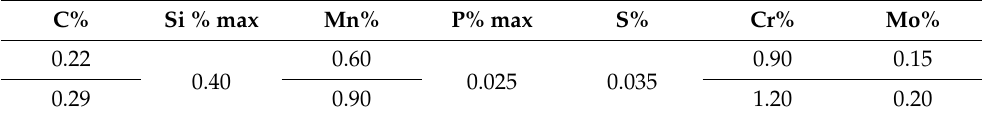
Table 2. Chemical composition of 25CrMo4 [9].